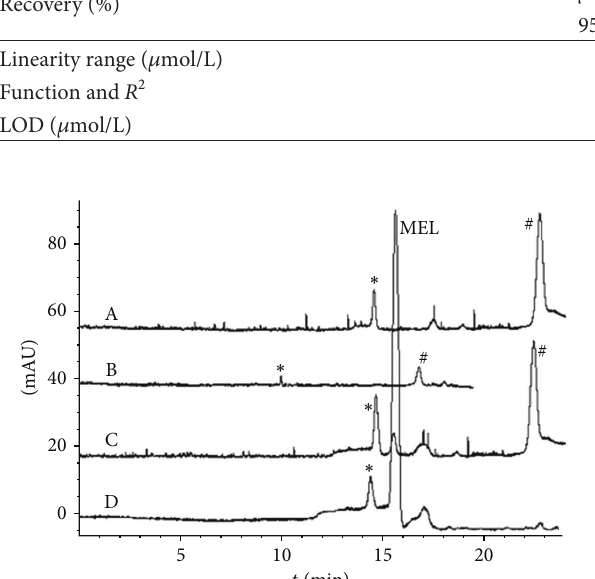
Figure 6: Electropherograms of real milk samples under optimized condition. (A)/(B)/(C) were samples from YILI pure milk; (D) was from WANGZAI reconstituted milk. Samples were treated with 60% acetonitrile(v/v)andwereinjectedhydrodynamicallyat50 mBarfor 40 s.Allsamplesalsocontained8 mmol/LpH2.8phosphatesolution and partial samples were added with MEL ((B)/(C) 0.5 𝜇 mol/L; (D) 8 𝜇 mol/L). Stacking was performed under +10.0 kV and results were detected at 200.0